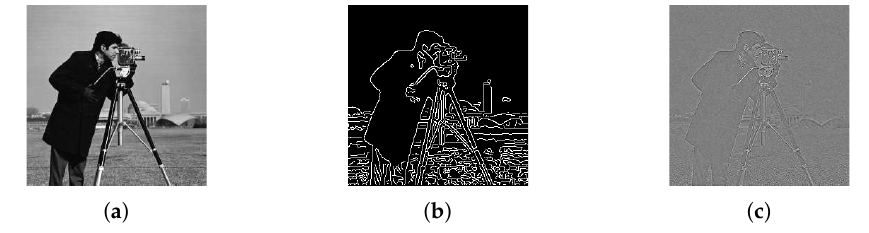
Figure 5. Image information at different levels. ( a ) Gray image. ( b ) Edge feature image. ( c ) Reconstructed image using phase